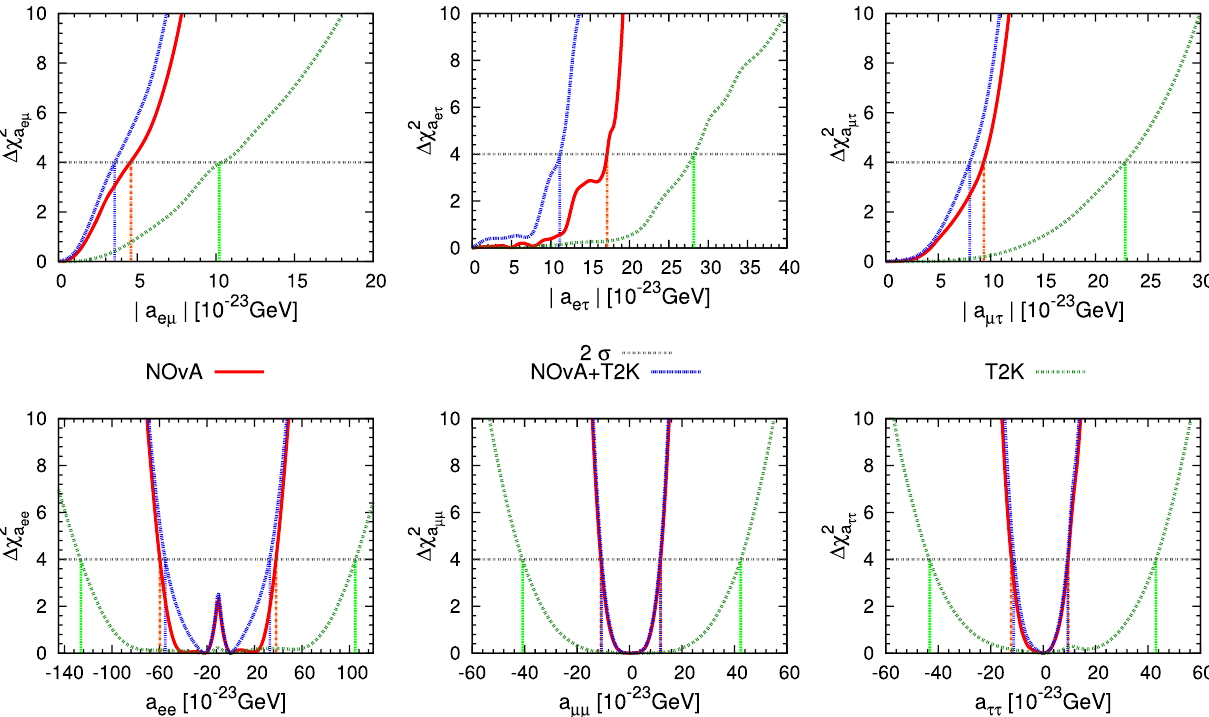
Fig. 4 The sensitivities on LIV parameters from NO ν A and T2K experiments [− π, π ] . Also the possibility of exclusion of CP conserving and for diagonal elements a ee , a μμ and a ττ , the correspond- phases has been shown by taking the test spectrum δ CP value ing plots are displayed by blue, green and red respectively. as 0, ± π . This exclusion sensitivity is obtained by calculat- Further, we show the sensitivity in presence of non-diagonal after doing marginalization over ing the minimum (cid:8)χ 2 LIV parameters in e μ , e τ , and μτ sectors respectively in the min and sin 2 θ 23 in both hierarchies NH and IH, as well as (cid:8) m 2 top right, bottom left, and bottom right panels of the same fig- 31 their 3 σ ranges. The CPV sensitivity for standard case and in ure. As the extra phases of the non-diagonal parameters can presence of diagonal LIV parameters is shown in the top left affect the CPV sensitivity, we calculate the value of (cid:8)χ 2 for a particular value of δ CP by varying the phase φ αβ in panel of Fig. 5. The black curve depicts the standard case,